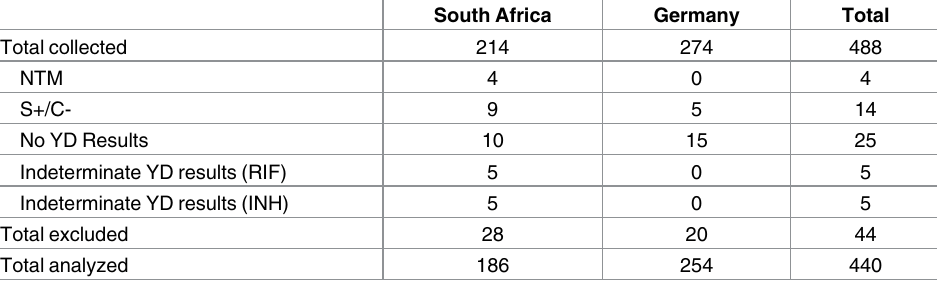
Table 5. Phase 2 sample characteristics and total number of samples included in the line probe assay comparative performanceassessment by